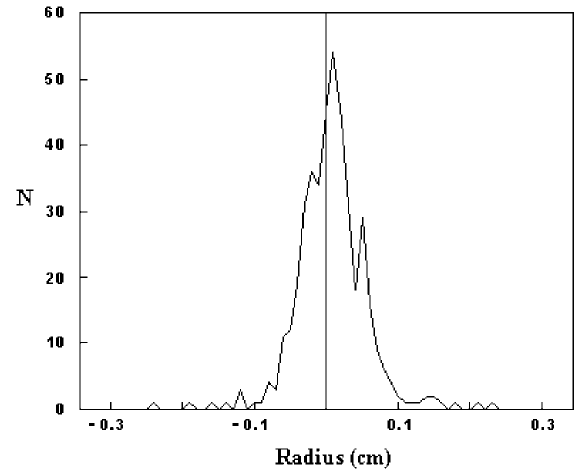
FIG. 7. Computed radial distribution.